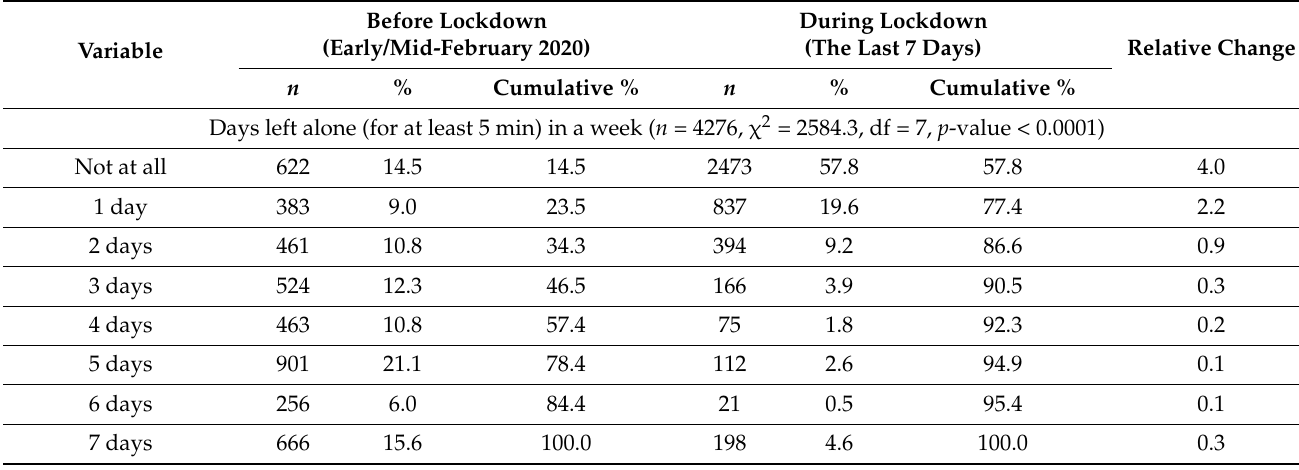
Table 2. The number of days/week and the maximum amount of time/day that the dog was reported to have been left alone in the home (during the last 7 days and during a week in early/mid-February 2020). Before Variable